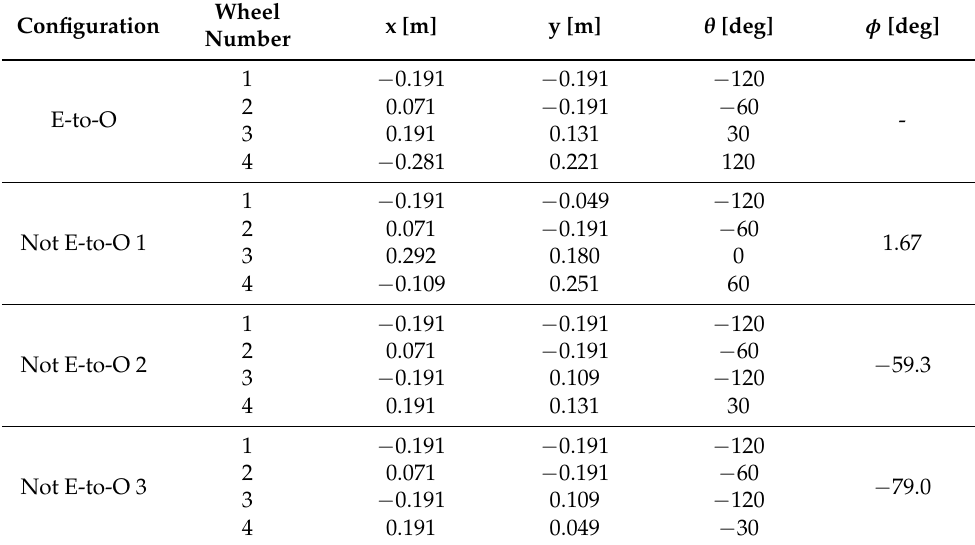
Table 2. Wheel arrangements of 4-wheeled Omni wheel robots.